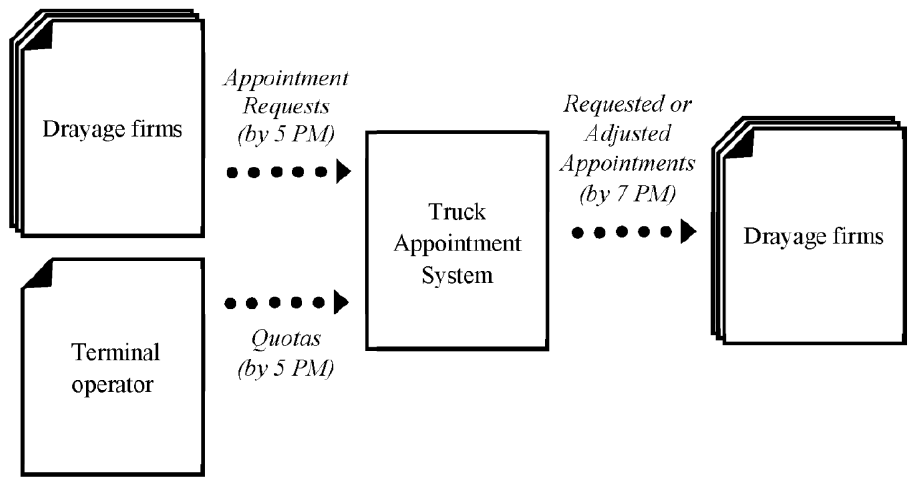
Figure 1. Appointment reservation process.